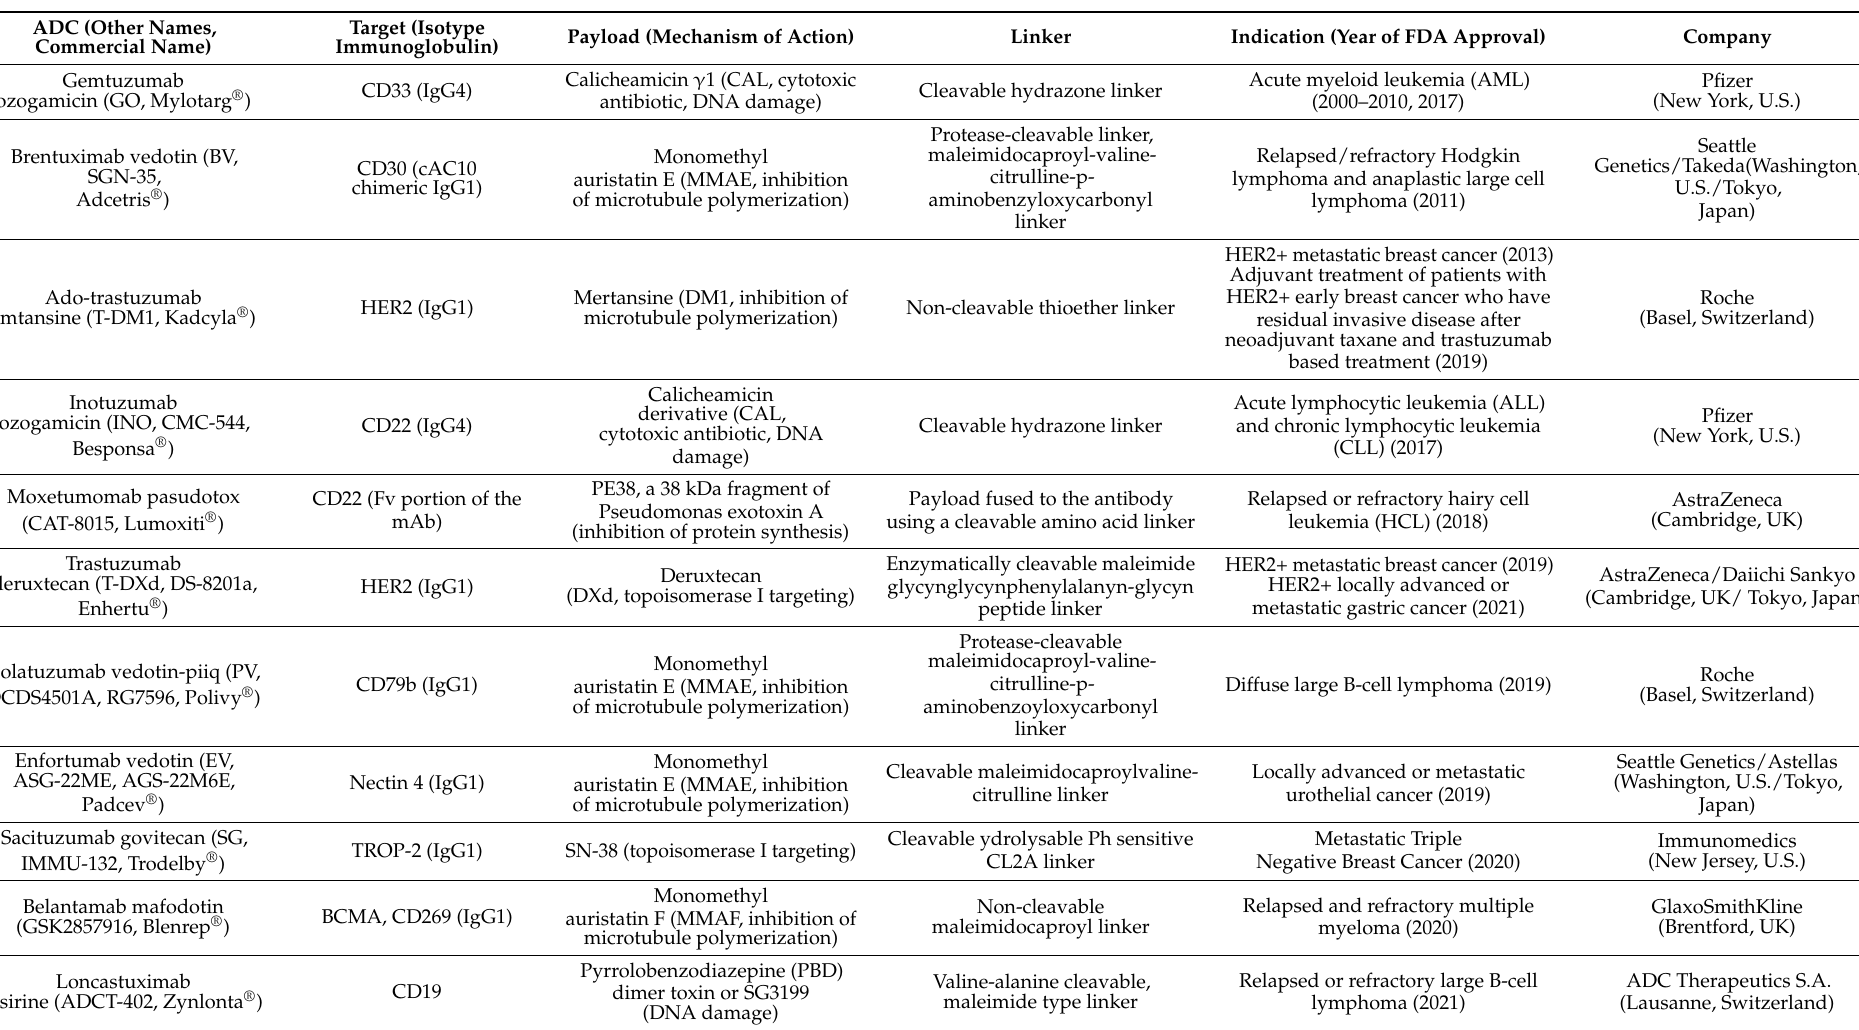
Table 1. ADCs approved by the